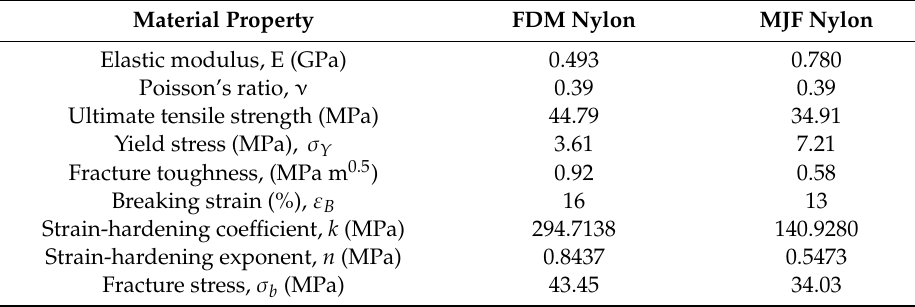
Figure 3. A typical tensile stress vs strain curve for the 3D-printed nylon specimens. Table 1. Mechanical properties of the 3D-printed nylon specimens.